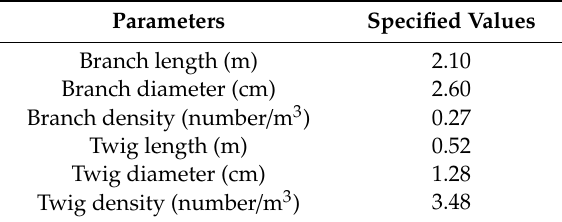
Table 5. The main canopy parameters of the plots for simulation.